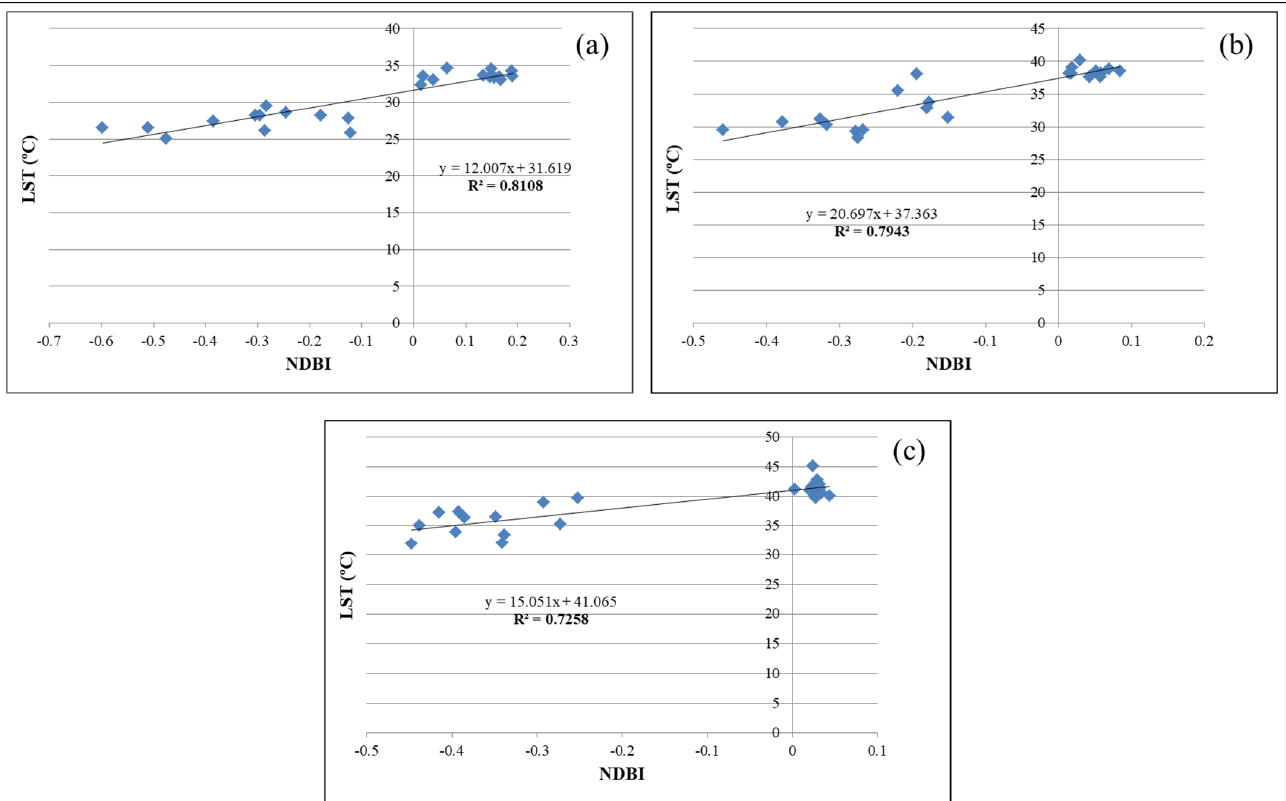
Figure 9. Regression analysis to retrieve the relationship between the LST and LULC over Gharbia in ( a ) 1991, ( b ) 2003, and ( c ) 2018.